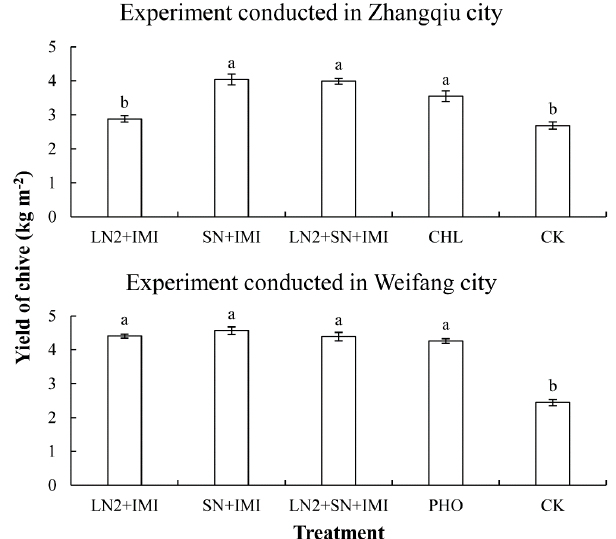
Figure 5. Average yields of chive in the plots with different treatments in the experiments conducted in Zhangqiu and Weifang city in China, in 2016–2017. LN2: Heterorhabditis indica LN2 applied at 3.0 × 10 9 IJ·ha − 1 ; SN: Steinernema feltiae SN applied at 3.0 × 10 9 IJ·ha − 1 ; Imi: imidacloprid at 1/10